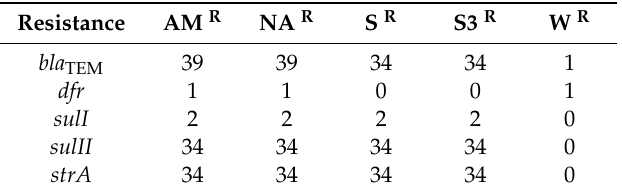
Table 1. Phenotypical resistance and resistance gene combination in clinical E. coli isolates from a chronic urinary tract infection (UTI) of a